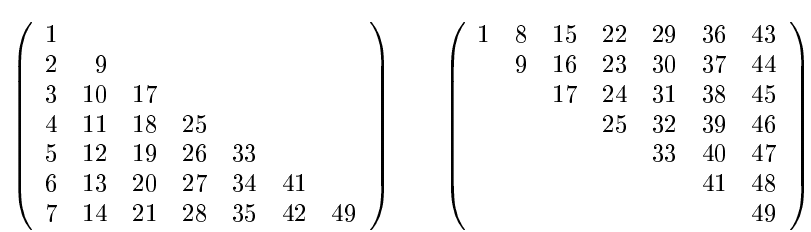
Figure1.Themappingof7(cid:2)7matrixfortheLAPACKCholeskyAlgorithmusingthe